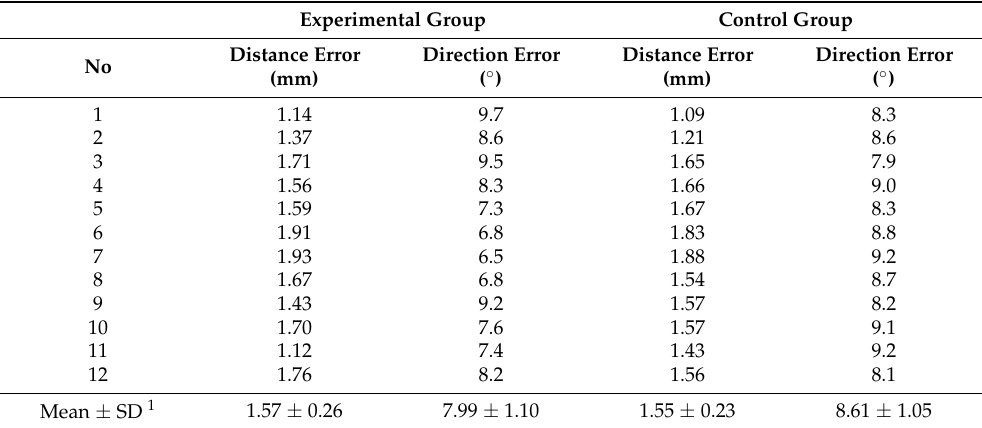
Table 1. The operative results.